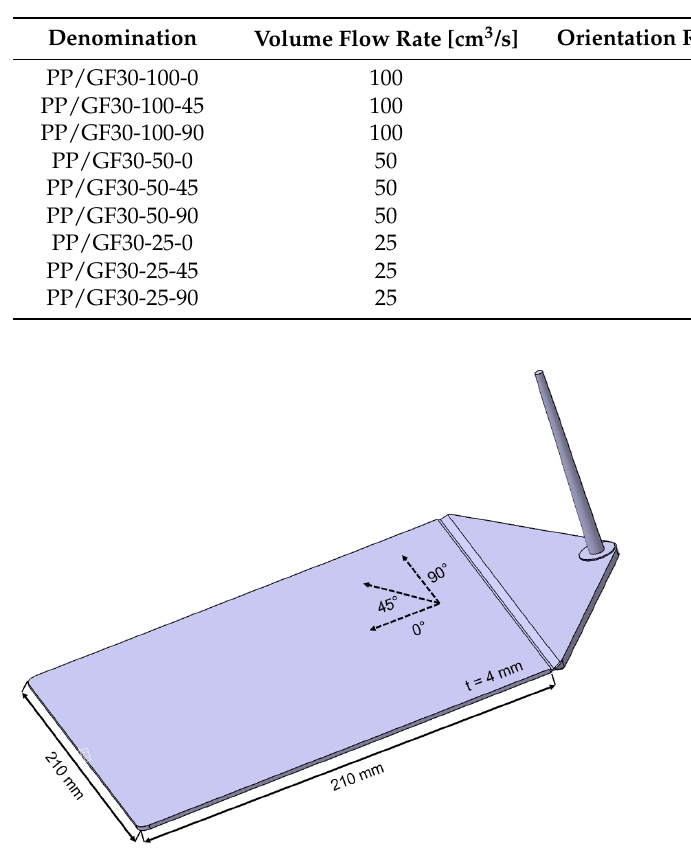
Figure 1. Geometry of the injection molded test plates made of PP/GF30 short fiber-reinforced thermoplastic composite.